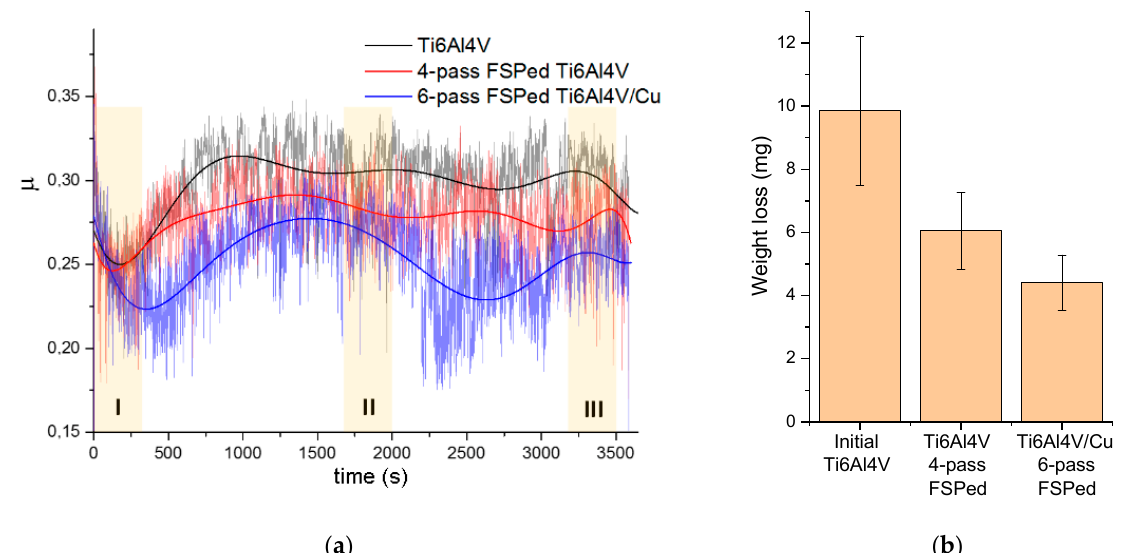
Figure 16. Coefficient of friction ( a ) and wear ( b ) vs. sliding time. The black, red, and blue curves were obtained by applying polynomial fitting procedures to the corresponding dependencies. I, II, and III are intervals chosen for analyzing the temperature behavior (Figure 17)